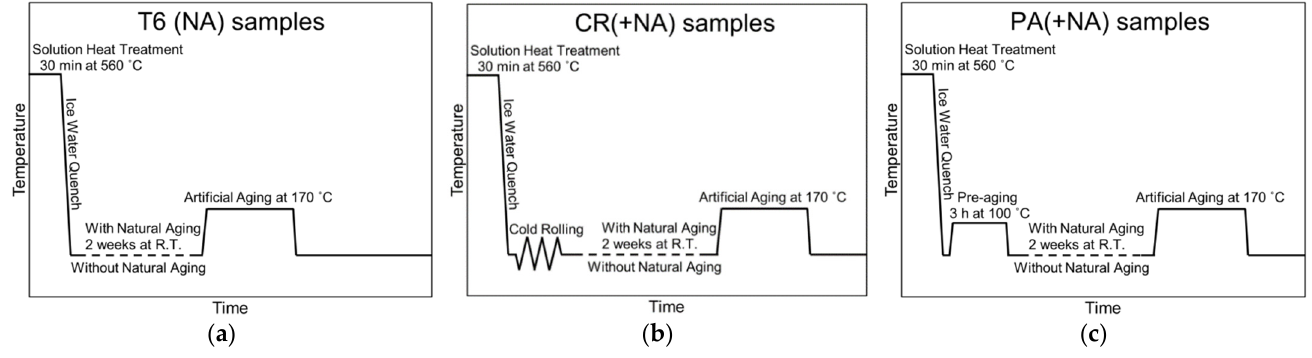
Figure 1. Schemes of thermo-mechanical process ( a ) T6 and NA processes, ( b ) CR and CR + NA processes and ( c ) PA and PA + NA processes.